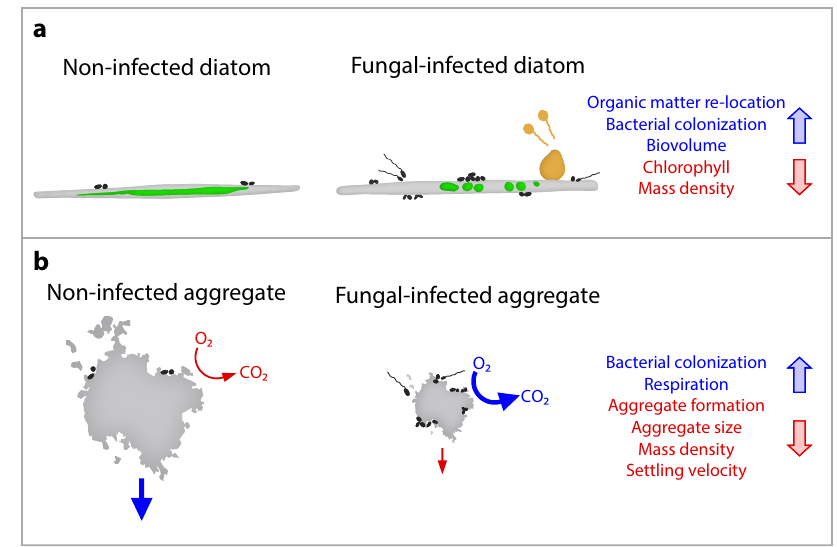
Fig. 7 Illustration of the impact of fungal parasites on biological and physical properties of single diatom cells and aggregates. The blue and red text and arrows indicate the fungal-induced increase and decrease of each property, respectively. Diatom cells a and aggregates b are illustrated in light grey, diatom chlorophyll in green, fungal sporangium and zoospores in orange, and bacteria in dark